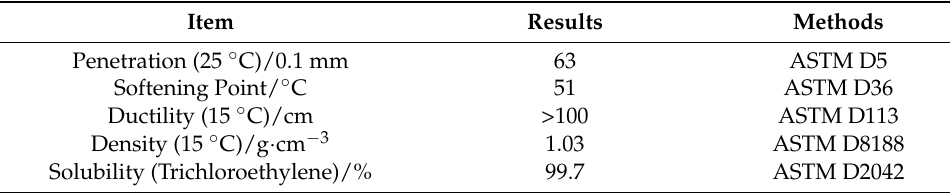
Table 1. Basic performances of the used asphalt